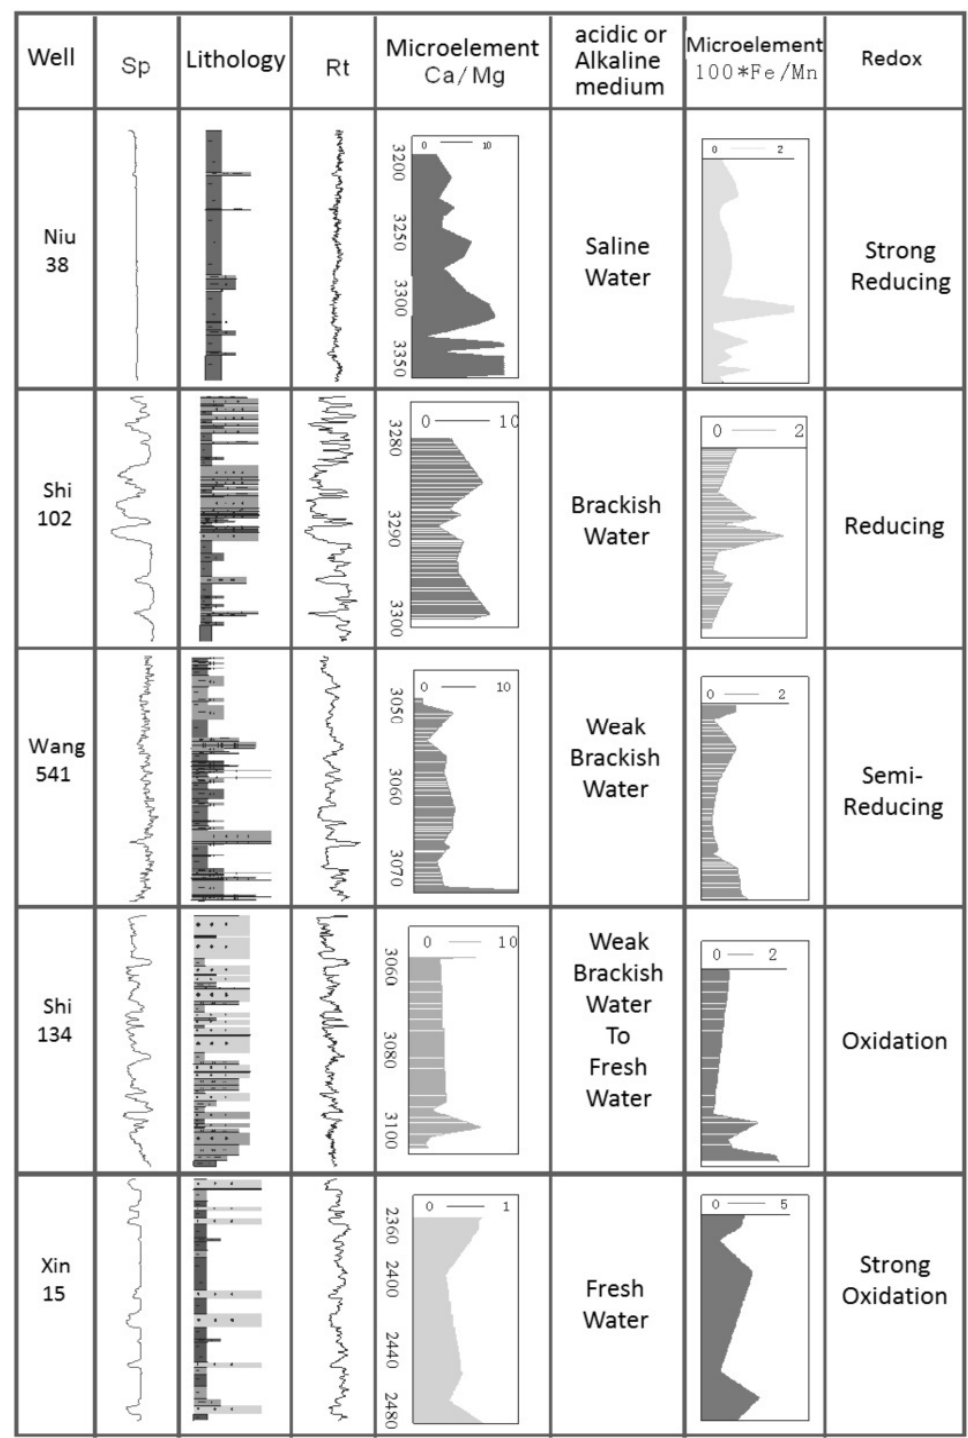
Figure 2. Variation of element ratios in different sedimentary environments of shale in Dongying